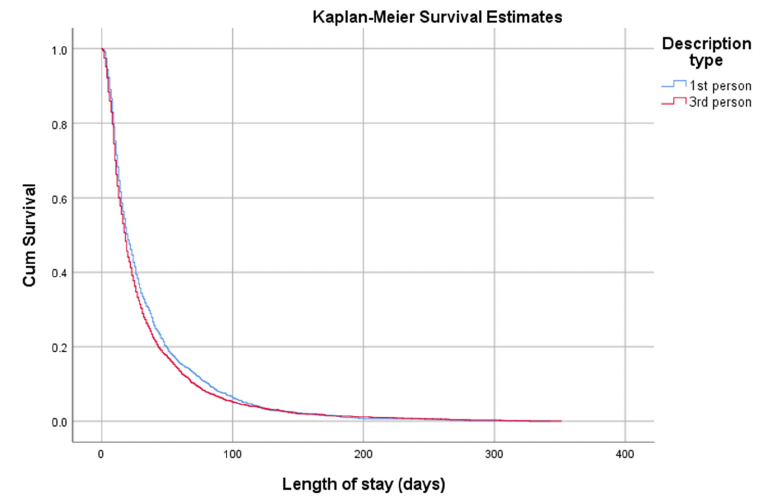
Figure 4. Kaplan-Meier survival curve of time-to-rehoming for cats according to the narrative voice of the adoption profile (first person vs. third person). Survival time represents the time from shelter admission to rehoming (LOS).